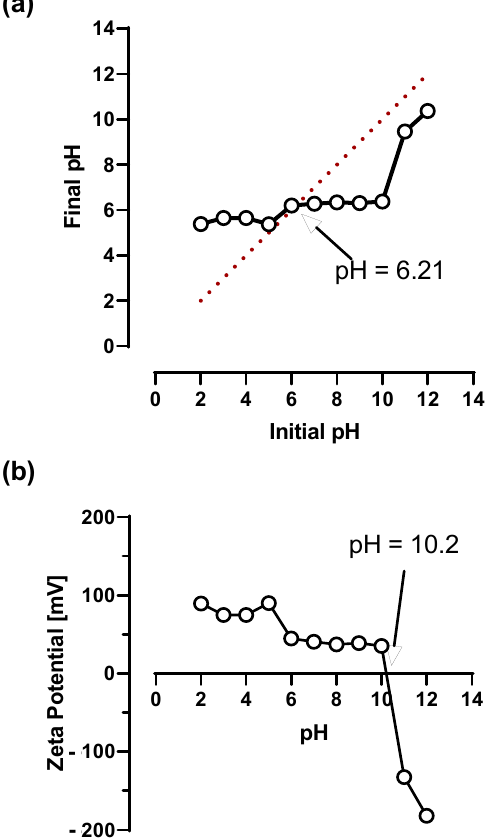
Figure 4. ( a ) Point zero charge (pHpzc) plot final pH vs. initial pHi and ( b ) zeta potential at a function of pH.